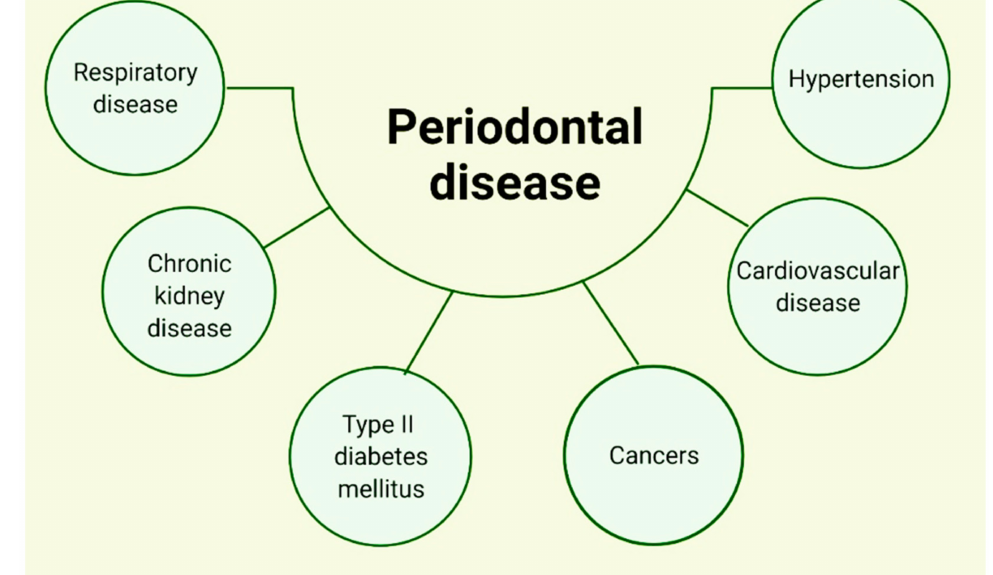
Figure 3. Relationship between different systemic pathologies and periodontal